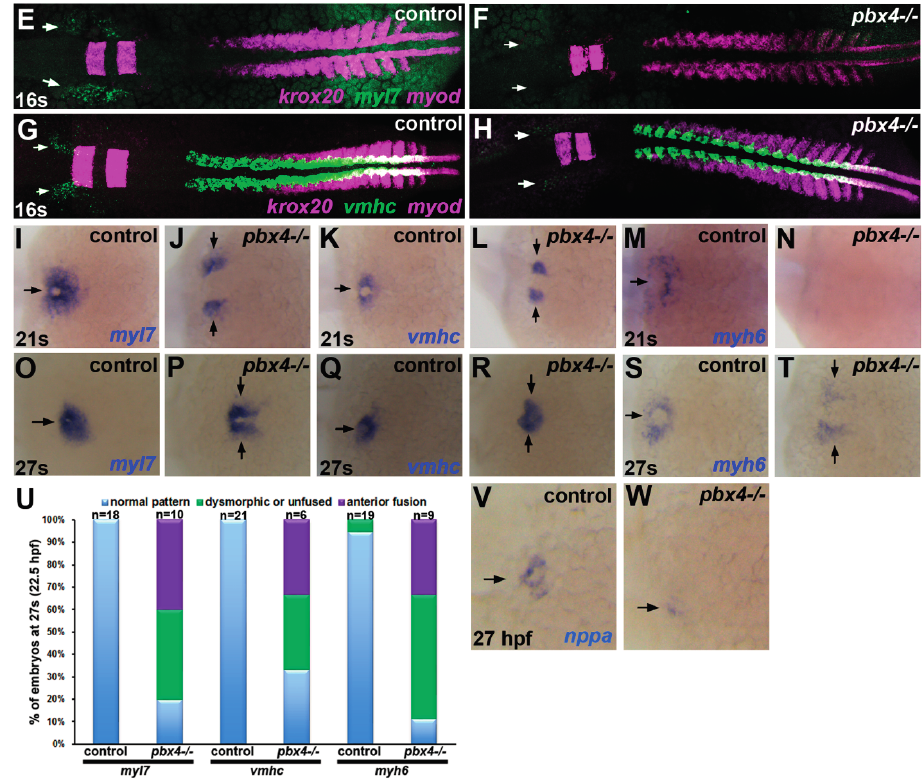
Figure 2. Delayed onset of cardiomyocyte differentiation genes in pbx4 mutant embryos. ( A – T , V – W ) RNA in situ expression of cardiomyocyte differentiation genes ( A – D ) tnnt2a , ( E – F , I – J , O – P ) myl7 , ( G – H , K – L , Q – R ) vmhc , ( M – N , S – T ) myh6 , and ( V – W ) nppa in ( A , C , E , G , I , K , M , O , Q , S , V ) control and ( B , D , F , H , J , L , N , P , R , T , W ) pbx4 b557 -/-